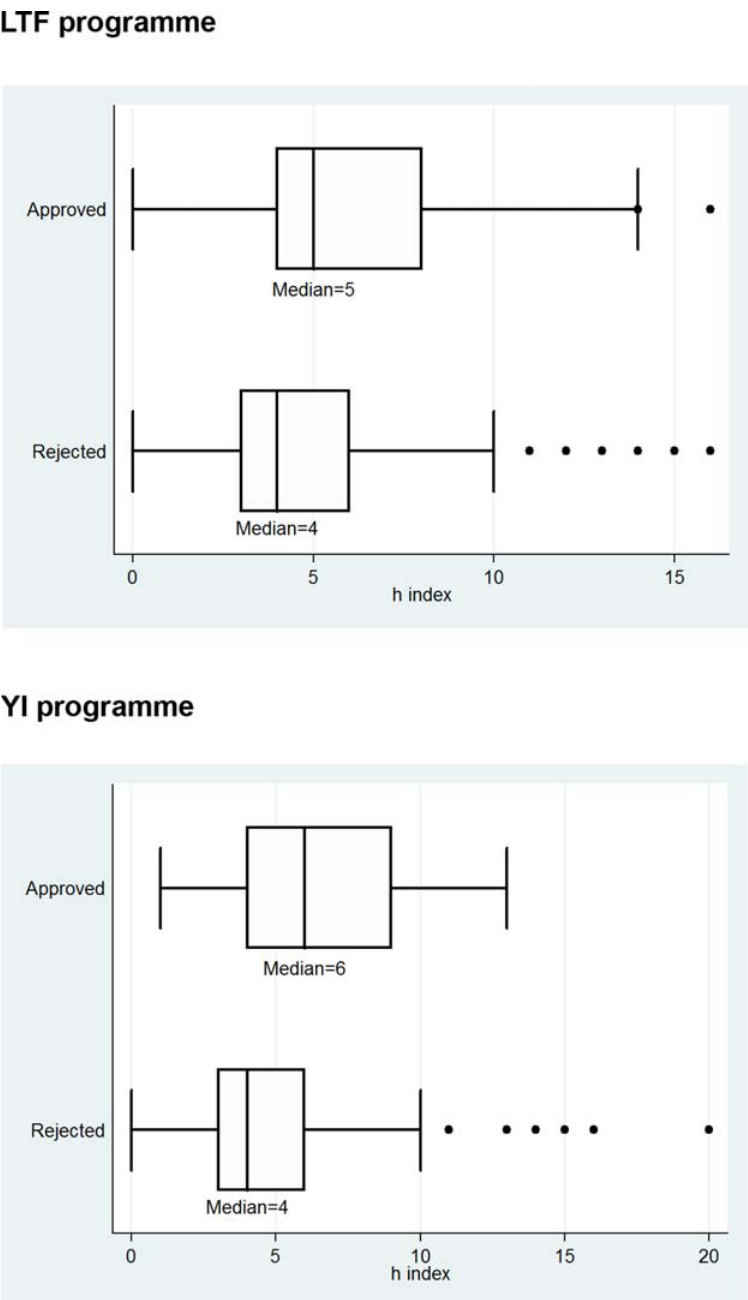
Figure 3. Box plots for h index values of approved and rejected applicants for the LTF and YI programme.